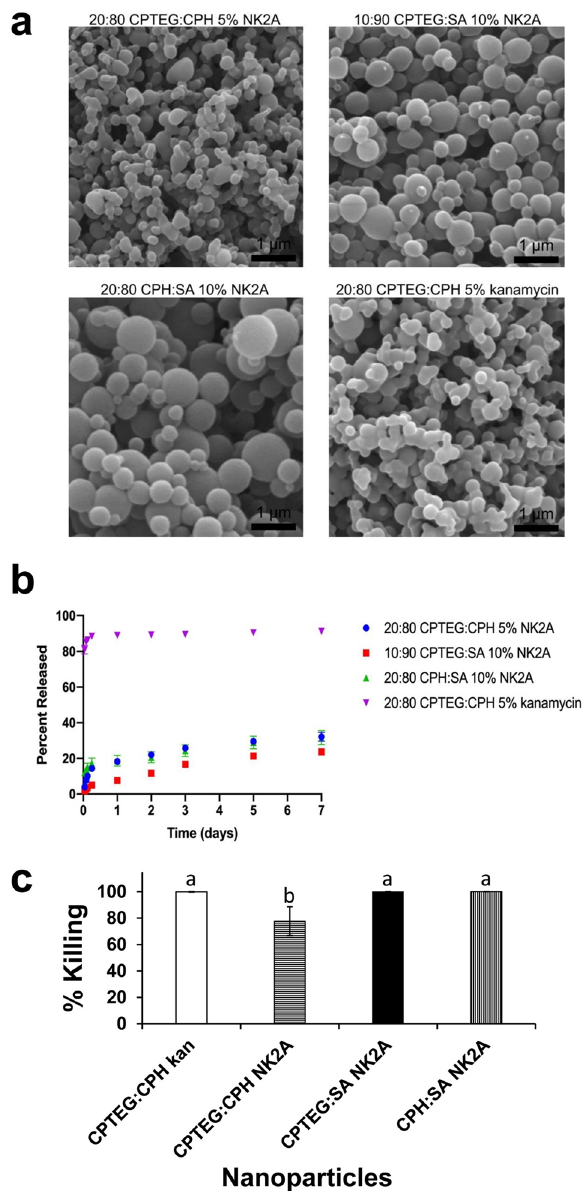
Figure 7. Characterization and killing efficacy of polyanhydride nanoparticles. ( a ) SEM micrographs of NK2A and kanamycin loaded polyanhydride nanoparticles. ( b ) Nanoparticle release kinetics of NK2A and kanamycin in PBS, pH 7.4 were determined by microBCA assay or o -pthalaldehyde derivatization followed by spectroscopy, respectively. ( c ) Salmonella outbreak isolate SX238 was incubated with NK2A (final concentration = ~ 5 μM), kanamycin (kan; final concentration = ~ 16 μg/mL) nanoparticles, or empty nanoparticles (negative control) for 3 h. Samples were serially diluted in LB broth, plated on to XLT plates, and bacterial colonies were enumerated after overnight incubation. Percentages of bacterial killing are presented as mean ± SD from three independent experiments. Bars with no common letters (a and b) differ significantly ( P < 0.0001) as determined by ANOVA test using GLM procedure from SAS software, Version 9.4 of the SAS System for